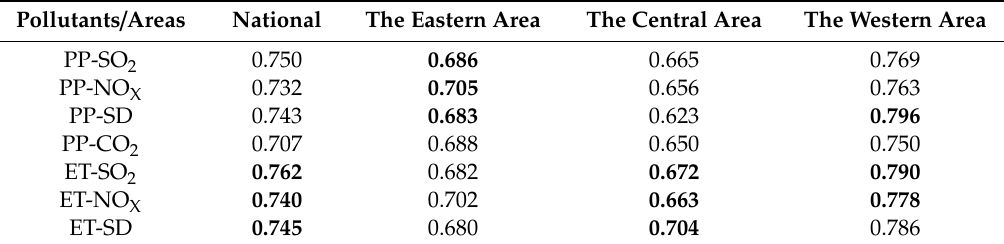
Table 6. The value of GRA.